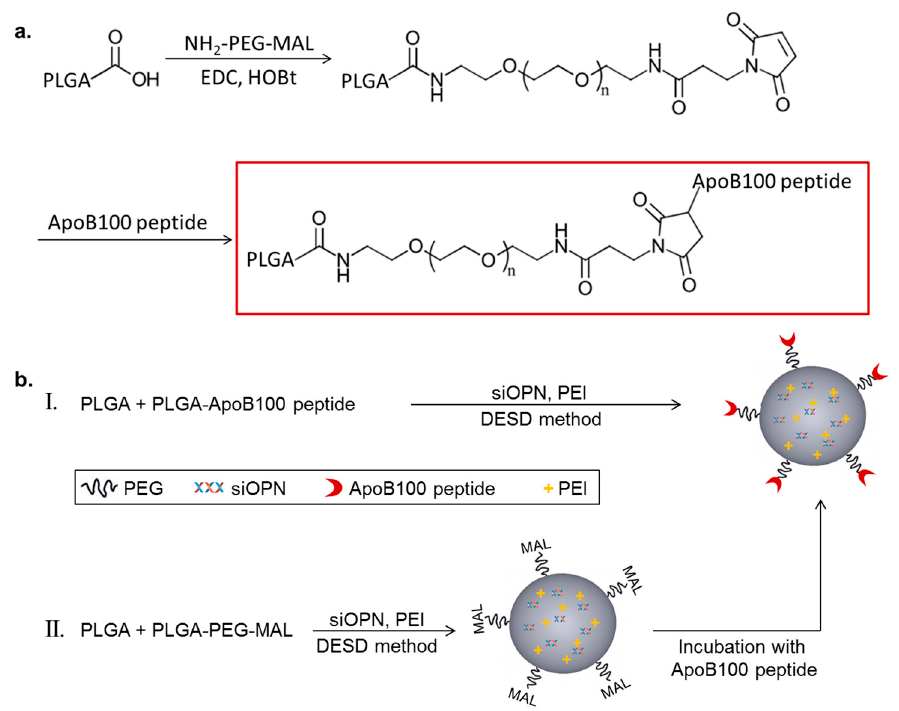
Figure 1. Schematic representation of Poly(D,L-lactic-co-glycolic acid) apolipoprotein B100 peptide (PLGA-ApoB-P) synthesis ( a ), and targeted nanoparticle (NP) preparation ( b ), by two methods (I and II).